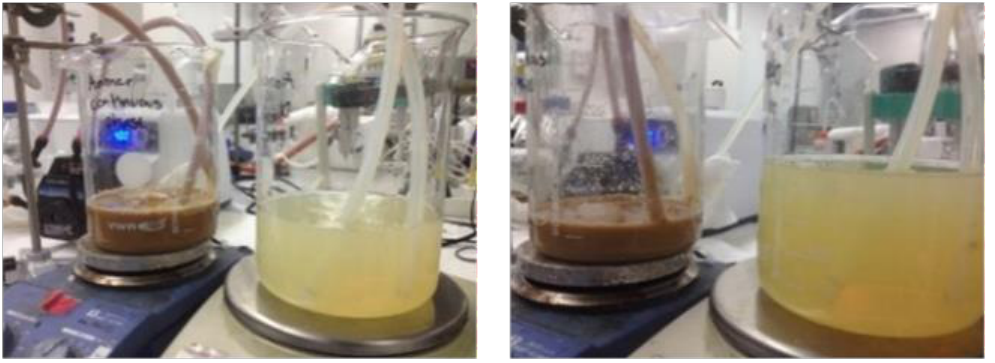
Figure A1. Emulsion formation as function of experimental time (from 0–3.5 h) for the experiments carried out at 0.25 bar pressure.